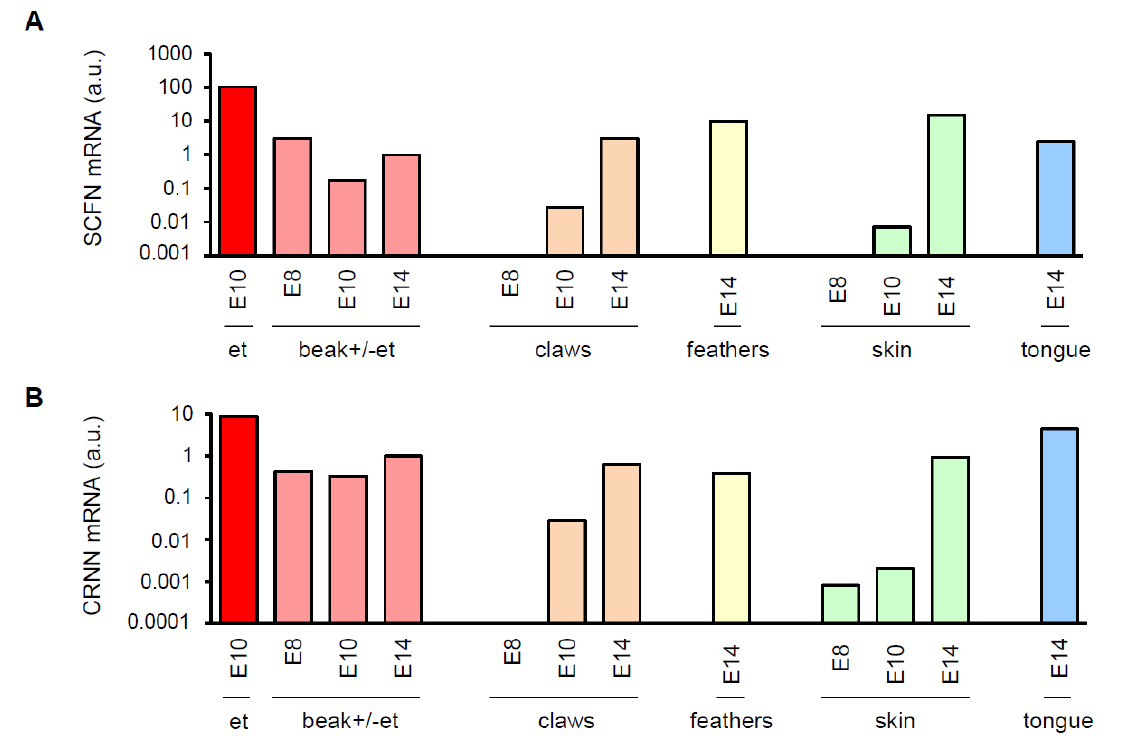
Figure 3. SFTP mRNAs expressed during embryonic development of quails. Indicated tissues were collected from quail embryos at developmental stages E8, E10 and E14, RNA was extracted, re-transcribed into cDNA and real-time PCRs were performed. mRNA levels of SCFN ( A ) and CRNN ( B ) are shown in arbitrary units (a.u.) which were calculated by normal- ization to the housekeeping gene HPRT1 in the same tissue and dividing the normalized value of each tissue by the nor- malized expression level in the beak sample of stage E14. The RNA of the egg tooth (et) and the remaining beak of the E10 embryo was extracted separately.